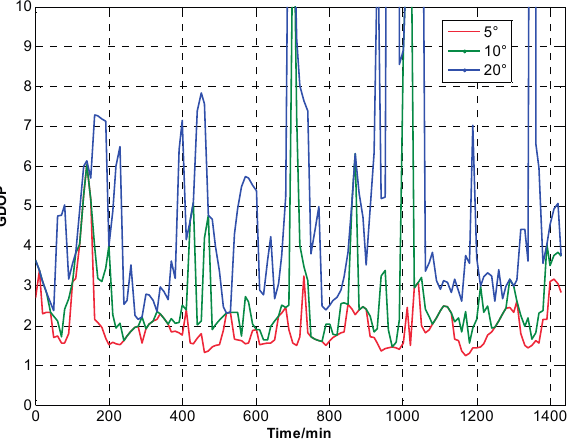
Figure 4. GDOP at different cutoff